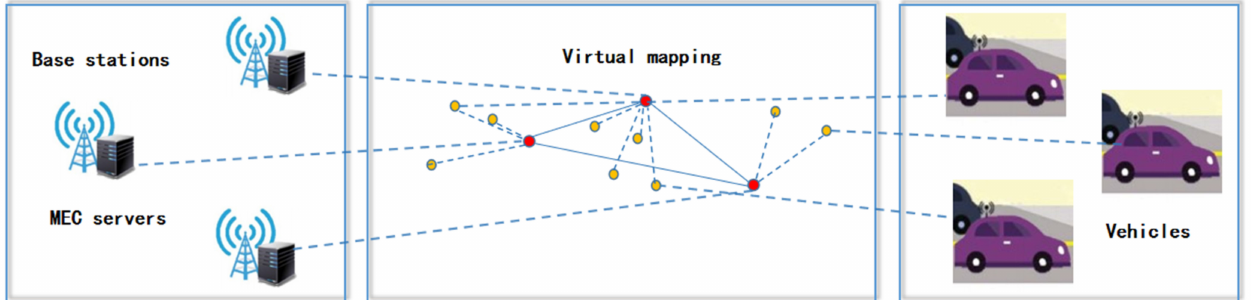
Figure 1. Blockchain-based MEC Network. The requesting vehicles and MEC servers in the MEC network are mapped as different nodes in the blockchain, where the MEC servers are mapped as nodes of performing block generation and validation, and the requesting vehicles are mapped as light nodes of only performing actions.